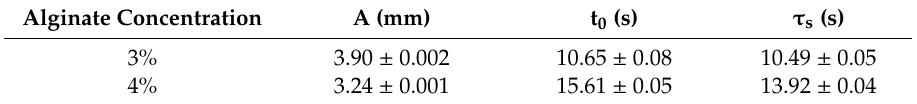
Table 6. Resulting fit parameters for the used asymptotic exponential fit function from Equation (17).